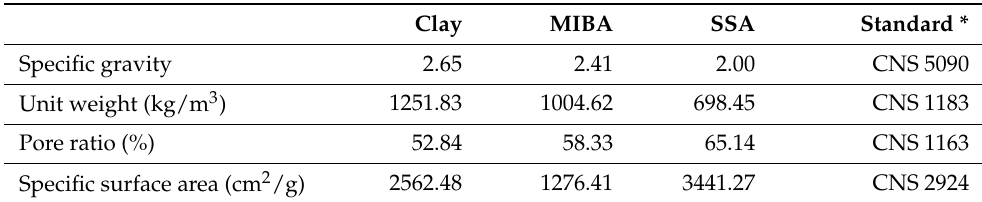
Table 1. Physical properties of the three raw materials.